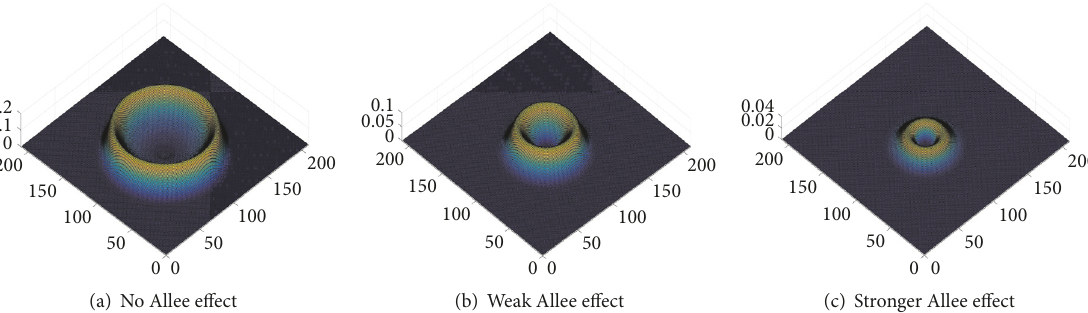
Figure 8: Density of proliferating cells without Allee effect, with weak Allee effect ( 𝑚 = 0.4 ), and with stronger Allee effect ( 𝑚 = 0.1 ) at 𝑡 = 20